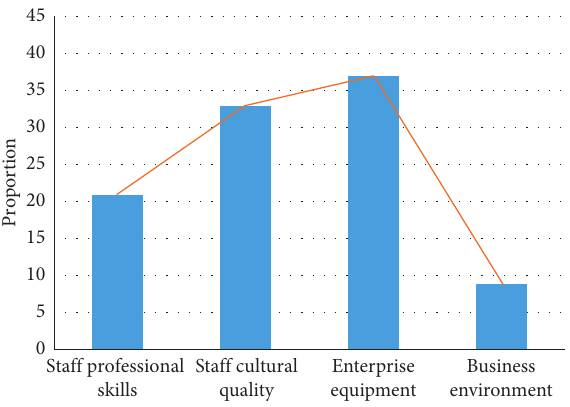
Figure 7: The standardized corporate image with strong competitiveness.